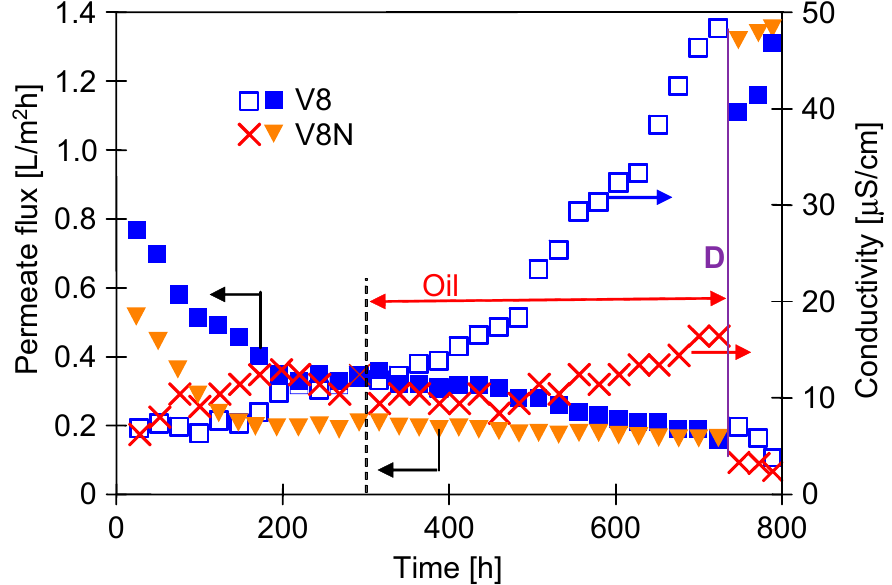
Figure 9. Changes in the permeate flux and the conductivity of the distillate during MD realized in a two-chamber installation MDC. Feed: saturated NaCl at 318 K and oil—78 mg/L. Point D—feed 100 g NaCl/L. Temperature: feed tank 328 K and crystallizer 318 K. Module M5 (V8) and M6